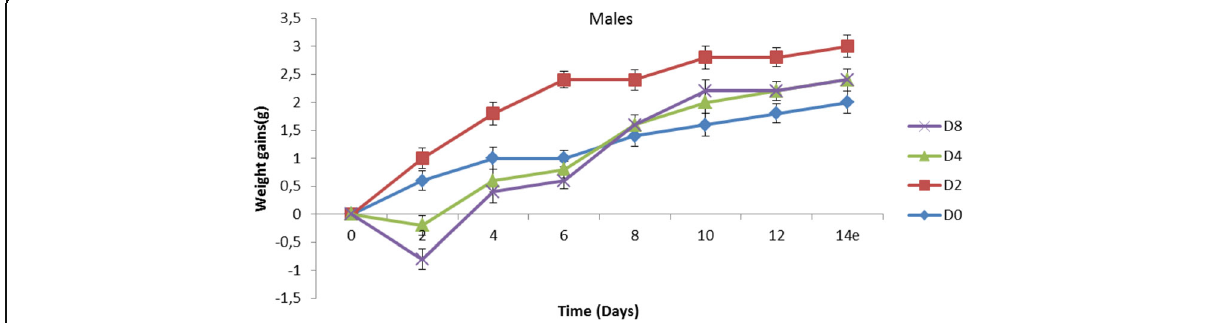
Fig. 1 Trends in mean body weight gains of male mice after single dose oral administration of A. cordifolia leaves extract. D0 = distilled water, D2 = 2 g/kg, D4 = 4 g/kg, D8 = 8 g/kg